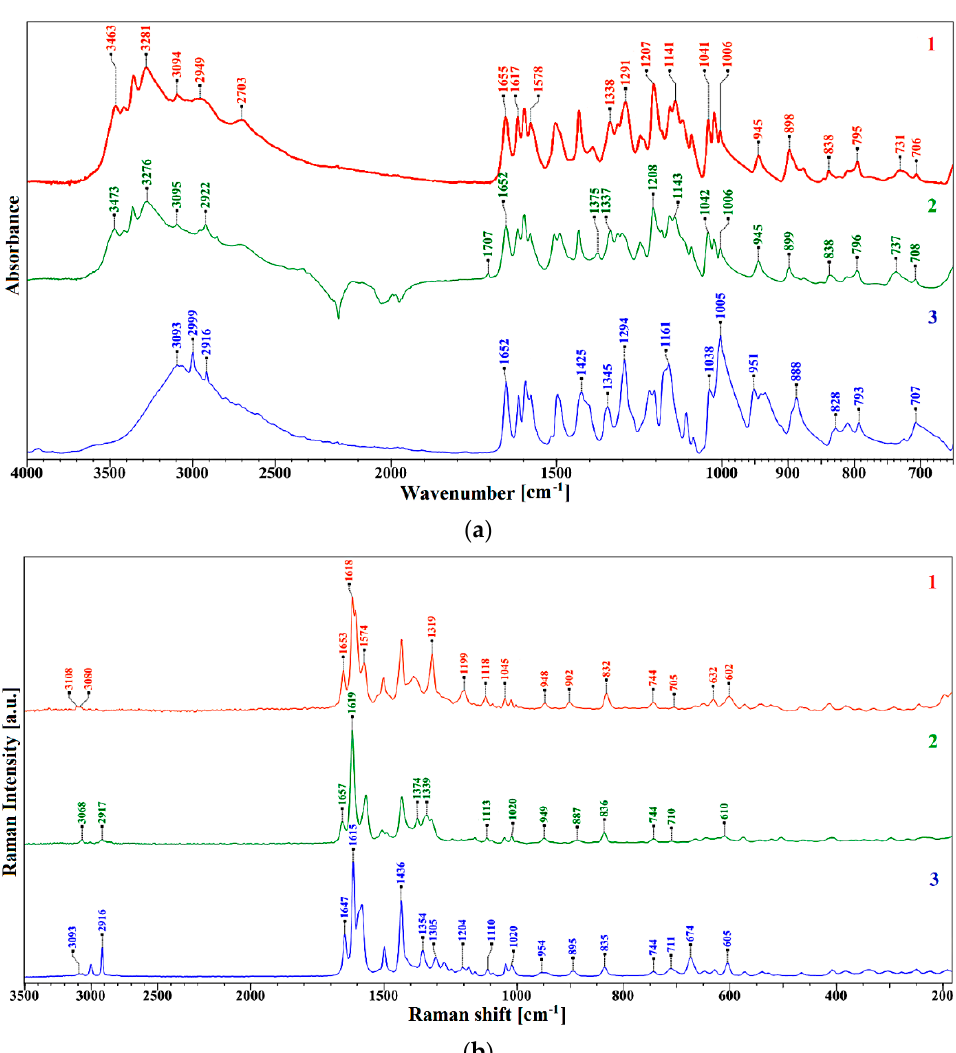
Figure 10. ( a ) FTIR-ATR and ( b ) FT-Raman spectra of complexes 1 – 3